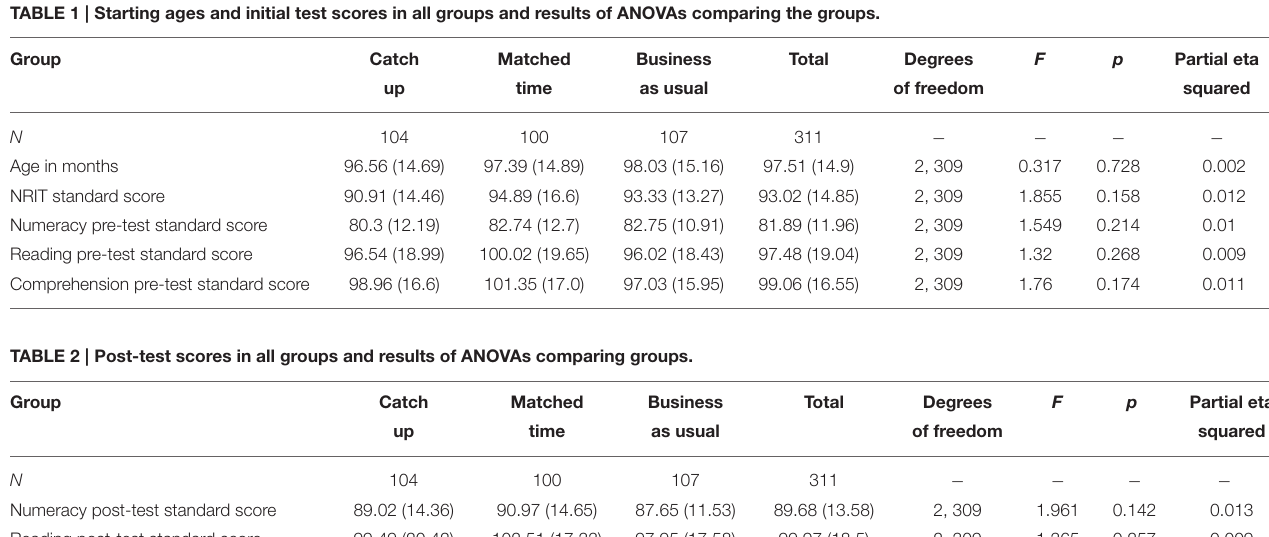
TABLE 1 | Starting ages and initial test scores in all groups and results of ANOVAs comparing the groups. Group Catch Matched Business Total Degrees F p Partial eta up time as usual of freedom squared N